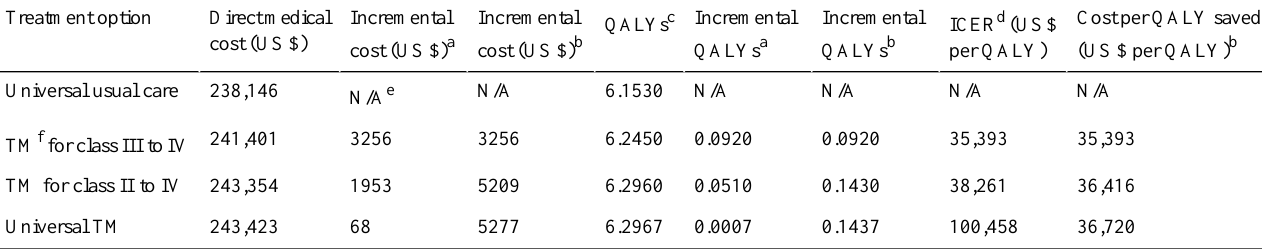
Table 1. Base case